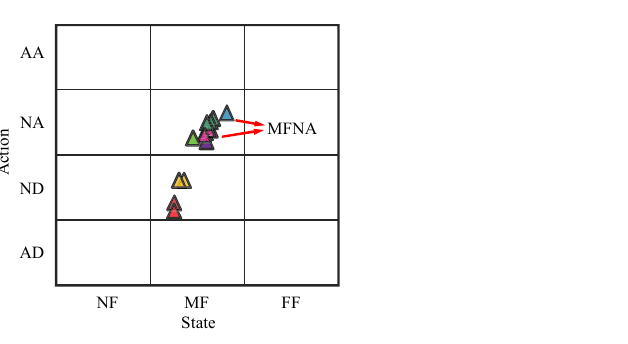
Figure 13. Example of clustering results for driver #5 using the K–means clustering method based on the HDP–HSMM with K = 1.